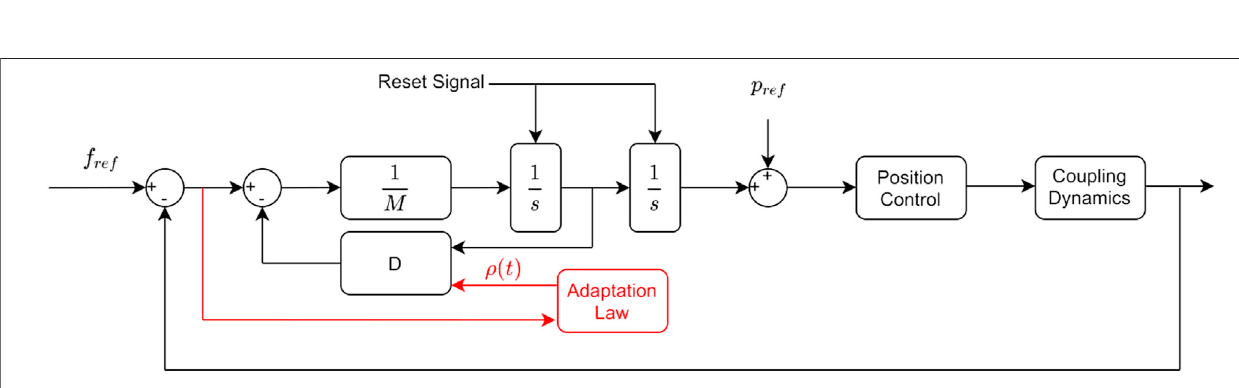
Frontiers in Robotics and AI |